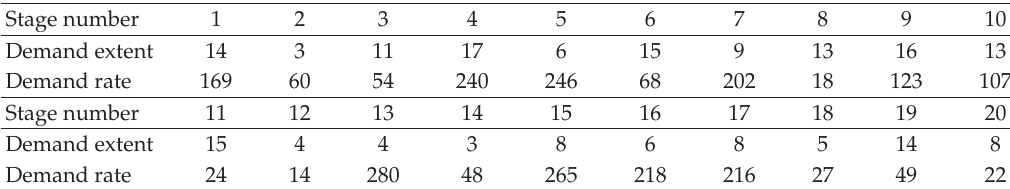
Table 2: Demand data in Problem 2.